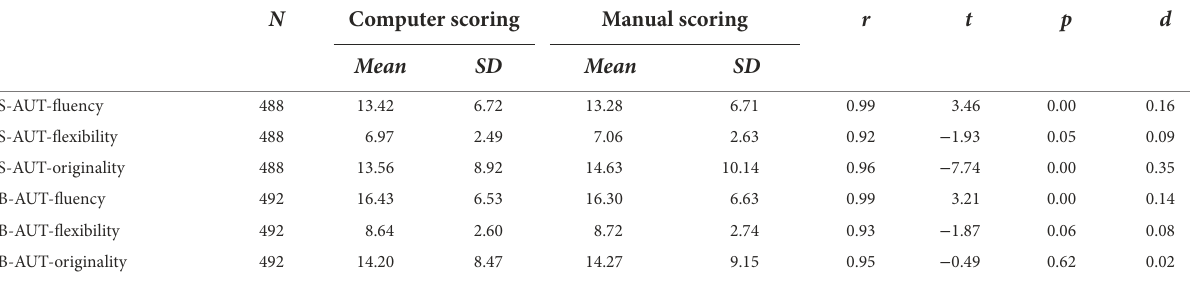
TABLE 3 Differences in Computer and Manual Scoring for